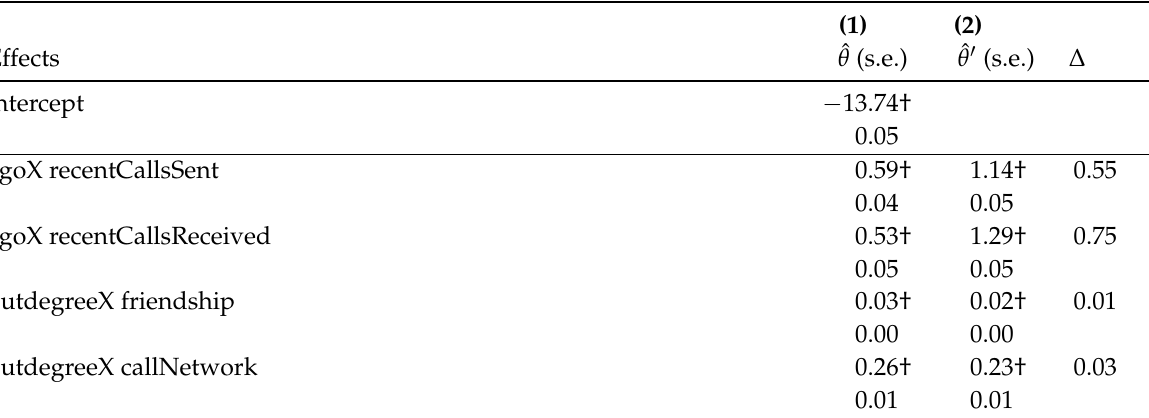
Table 2: Comparison of the bias of the DyNAM rate induced by ignoring right-censored